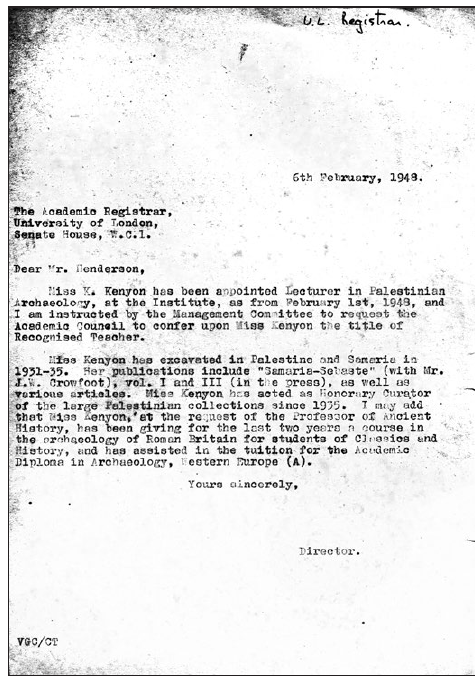
Figure 4: Letter confirming